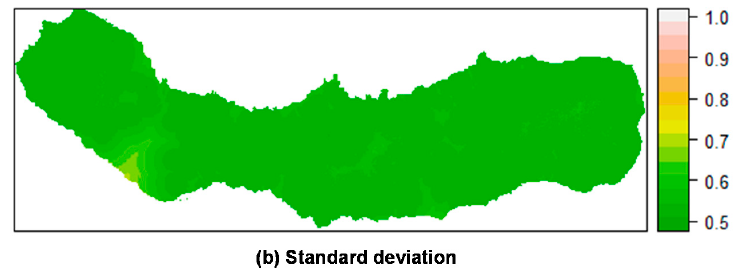
Figure 7. Prediction of P. undulatum occurrence in São Miguel Island by posterior mean ( a ) and standard deviation ( b ) of the linear predictor. Top: Mixed effects model including a random field; Bottom: Fixed effects model (without a random field). All models calculated using INLA.